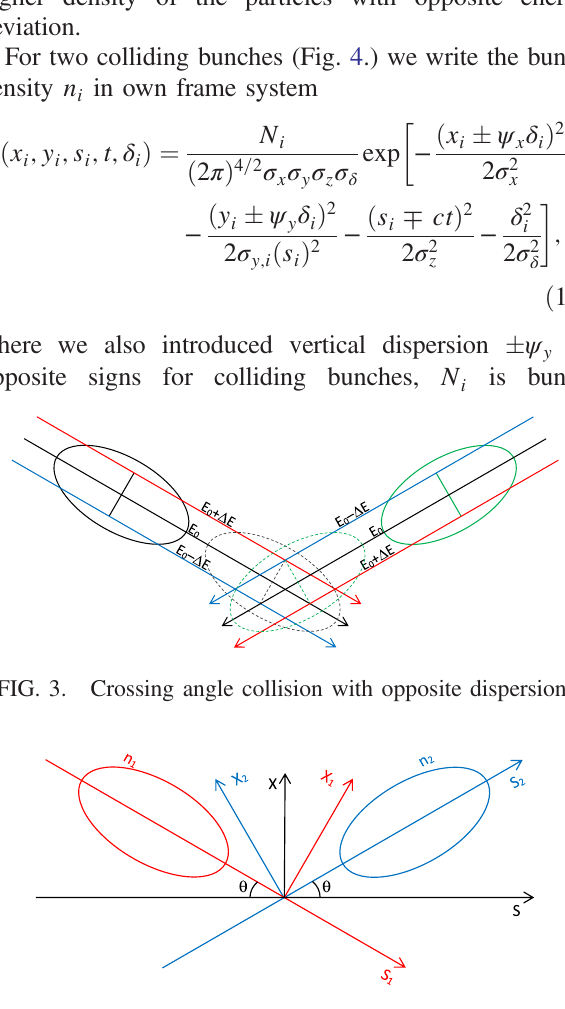
FIG. 4. Crossing angle collision with opposite